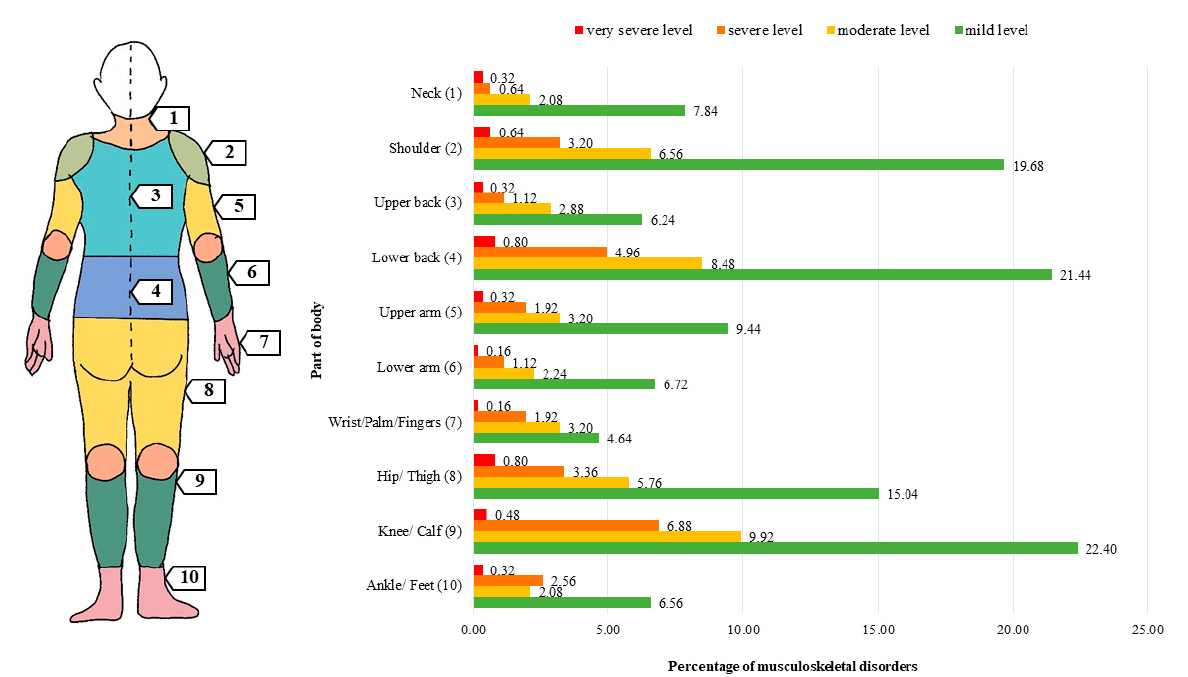
Figure 2. MSDs levels classified according to affected body parts.